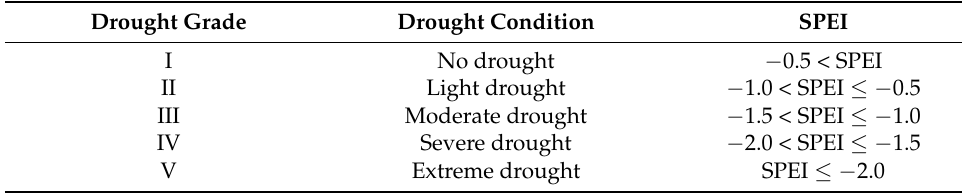
Table 3. SPEI’s classification criteria for grading drought. Drought Grade Drought Condition